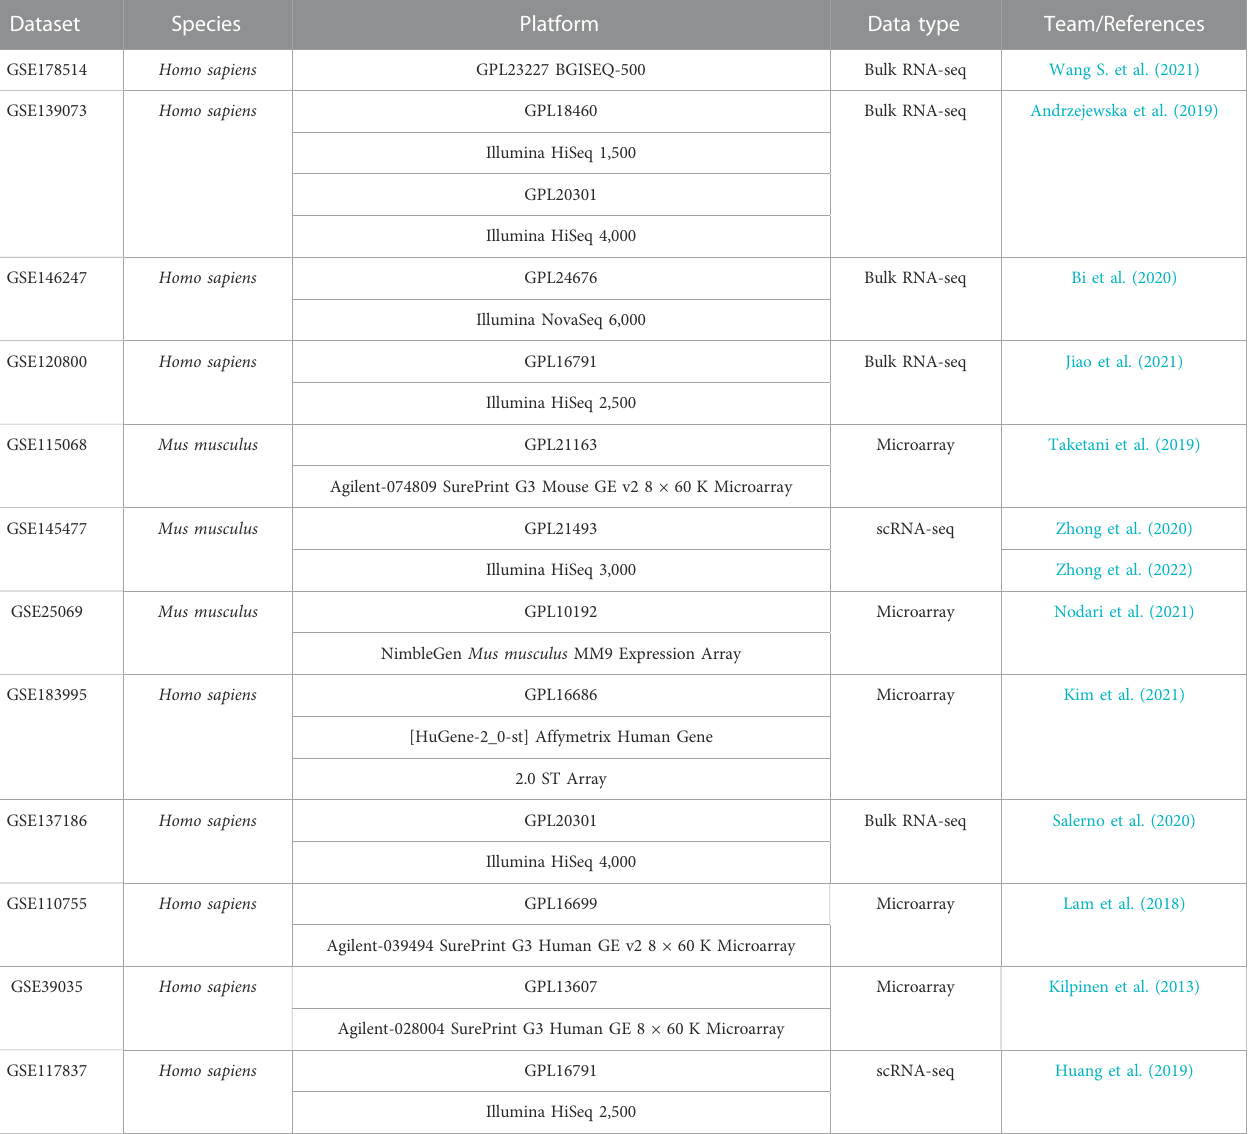
TABLE 1 The detailed information of 12 datasets analyzed in the present study.